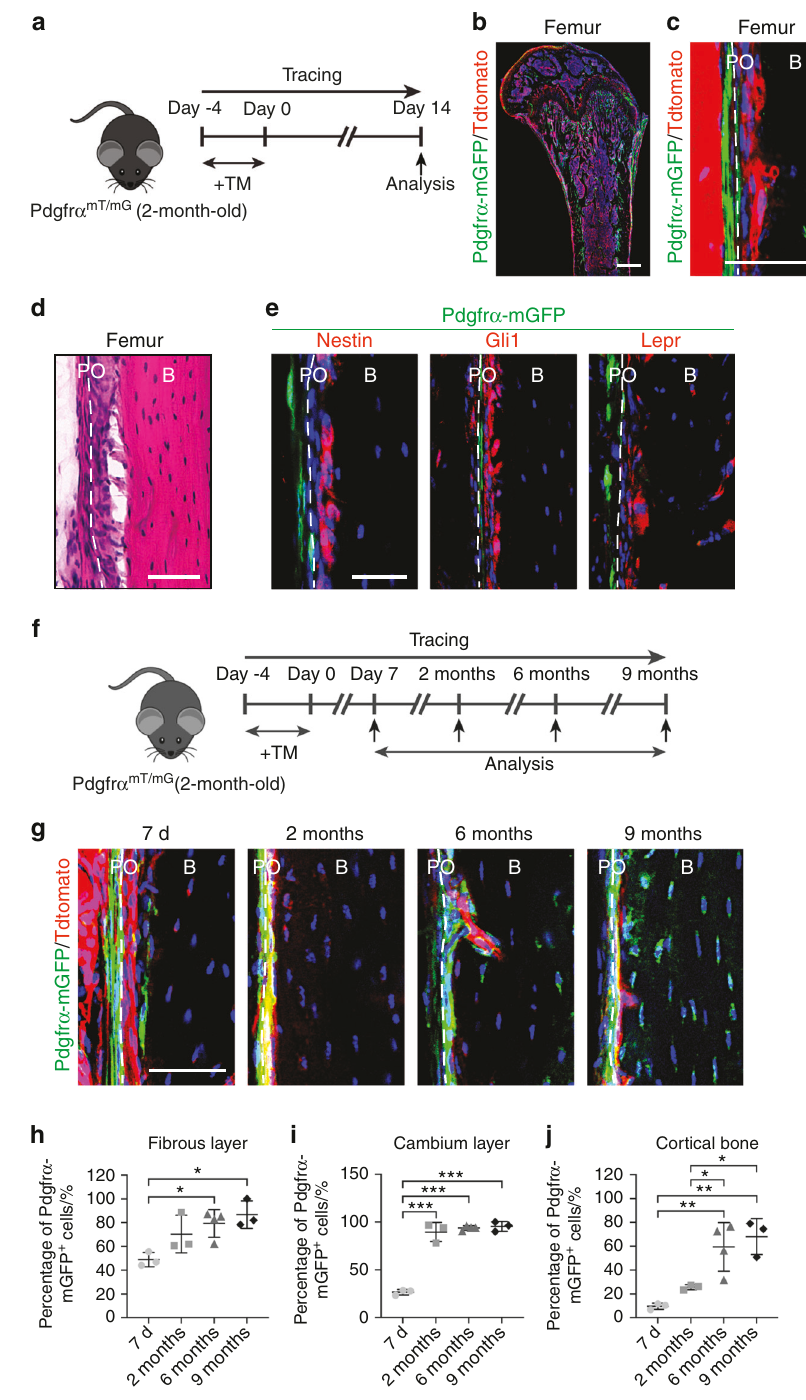
Fig. 1 PDGFR α reporter activity marks skeletal progenitor cells within the periosteum. a – e PDGFR α reporter activity is mainly present in the fi brous layers of the periosteum. a Schematic of the experiment: PDGFR α mT/mG animals (male, aged 2 mo) were administered tamoxifen (TM), and reporter activity was examined after 2 weeks. PDGFR α reporter + (GFP + ) cells were present in the femoral diaphyseal periosteum, as demonstrated by tile scanning ( b ) and at high magni fi cation ( c ). Nuclei, DAPI (4 ′ ,6-diamidino-2-phenylindole, blue). d Representative histologic appearance of the femoral periosteum observed by H&E staining. e Immunohistochemical staining for Nestin, Gli1, and Lepr within the femoral diaphyseal periosteum using PDGFR α mT/mG reporter sections and detection under a confocal microscope. GFP indicates reporter activity, and Tdtomato expression is not shown. f – j PDGFR α reporter + periosteal cells give rise to the cambium layer of the periosteum and osteocytes over time. f Schematic of the experiment: PDGFR α mT/mG animals (male, aged 2 mo) were administered TM, and reporter activity was examined after 7 d, 2 mo, 6 mo, and 9 mo. g Representative images of the PDGFR α mT/mG diaphyseal periosteum at different time points after TM injection. Percentage of PDGFR α reporter + cells in the fi brous periosteum ( h ), cambium periosteum ( i ), and osteocytes ( j ). B bone, PO periosteum. The dashed lines in c , d , e , and g indicate the limit between the inner and outer layers of the periosteum. Scale bars: 500 μ m ( b ) and 50 μ m ( c , d , e , g ). n = 3 – 4 animals per group. The dot plots represent an individual animal, and the whisker plots indicate the mean and one-SD values. * P < 0.05, ** P < 0.01 and *** P < 0.001, as assessed by one-way ANOVA with Tukey ’ s multiple-comparisons